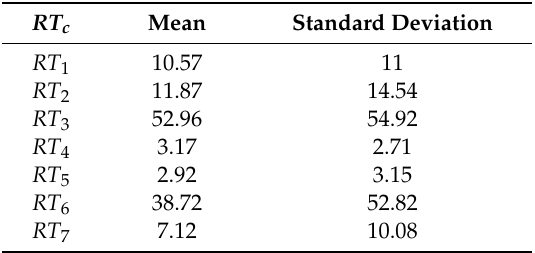
Table 5. Statistical characteristic of frequency by risk category.